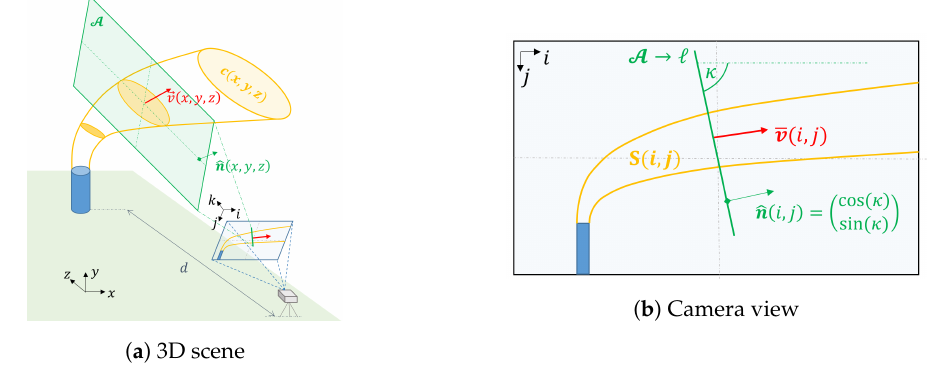
Figure 1. Measurement geometry-sketched ( a ) in three dimensions and ( b ) as the camera sees it. The emission plume is indicated in yellow colours, gas velocities in red. The orientation of the plume cross-section (PCS) A (green colours) is aligned with the camera optical axis k